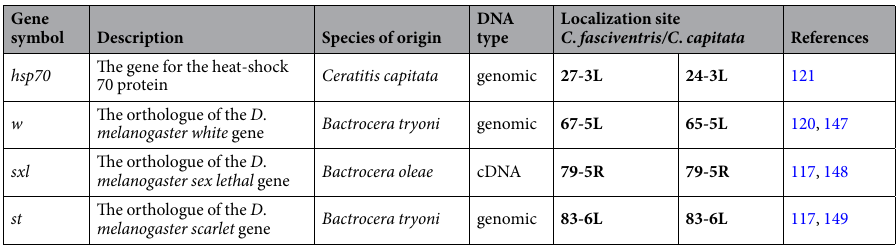
Fig. 5) is further support for the rearrangements of the 5L chromosome arm between the two species suggested by banding pattern analysis (Fig. 5). The banding pattern comparison and gene localization data provide evidence for the conservation of chro- mosome synteny between the closely related species C . capitata and C . fasciventris . However, a more thorough chromosome mapping analysis would be needed in order to confirm the above observation. The idea that the chromosome elements have maintained their basic content and identity was initially proposed for Drosophila species 122, 123 . Later comparative studies using biochemical and morphological markers showed a remarkable con- servation of linked gene clusters among a wider phylogenetic range of higher Diptera 124–126 . In situ hybridization of well characterized genes on polytene chromosomes further supported the extensive conservation of linkage groups in Tephitidae 70, 117, 127–131 . On the other hand, the differences identified in the structure of the 3L and 5L polytene arms of C . fasciventris and C . capitata , are congruent with the concept that chromosome rearrangements,